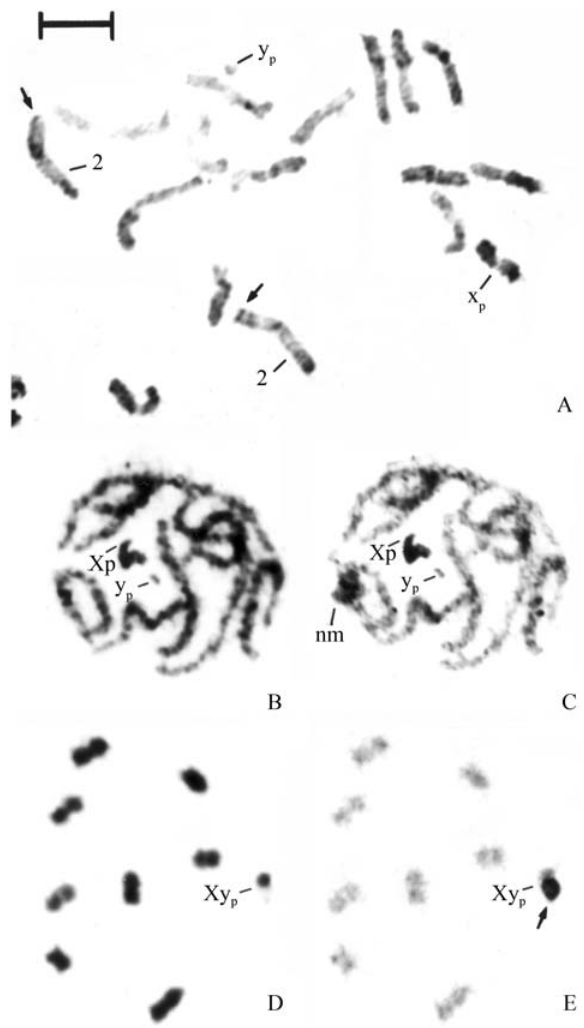
Figure5 -Testescellsof Astylusvariegatus aftersilverstaining(A,C,and E) and Giemsa staining (B and D). A) Mitotic metaphase, 2n = 16+Xy p , with one Ag-NOR on the short arm of the second pair (arrow). B-C) Pachytene, 2n = 8II+Xy p , with nucleolar material (nm) on one autosomal bivalent. D-E) Metaphase I, 2n = 8II+Xyp, with an argentophilic block be- tween the sex chromosomes (arrow). Scale bar = 5 μ